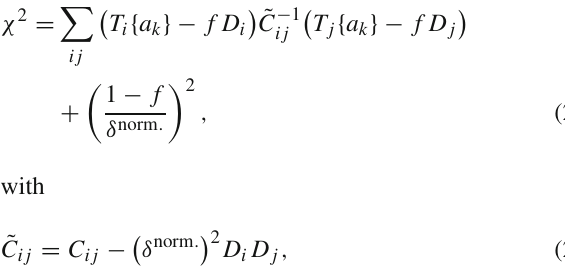
In Fig. 5 we plot the χ 2 profiles along each eigenvector direc- tion. In most of the cases the quadratic approximation seems to hold very well (in the plotted range) but in some cases its imperfections are also clearly visible. Our evaluation of the Hessian matrix follows the iterative procedure discussed more detailedly in Sect. 4.1 of Ref. [1]. The best fit corresponds to the origin of the z space, z i =